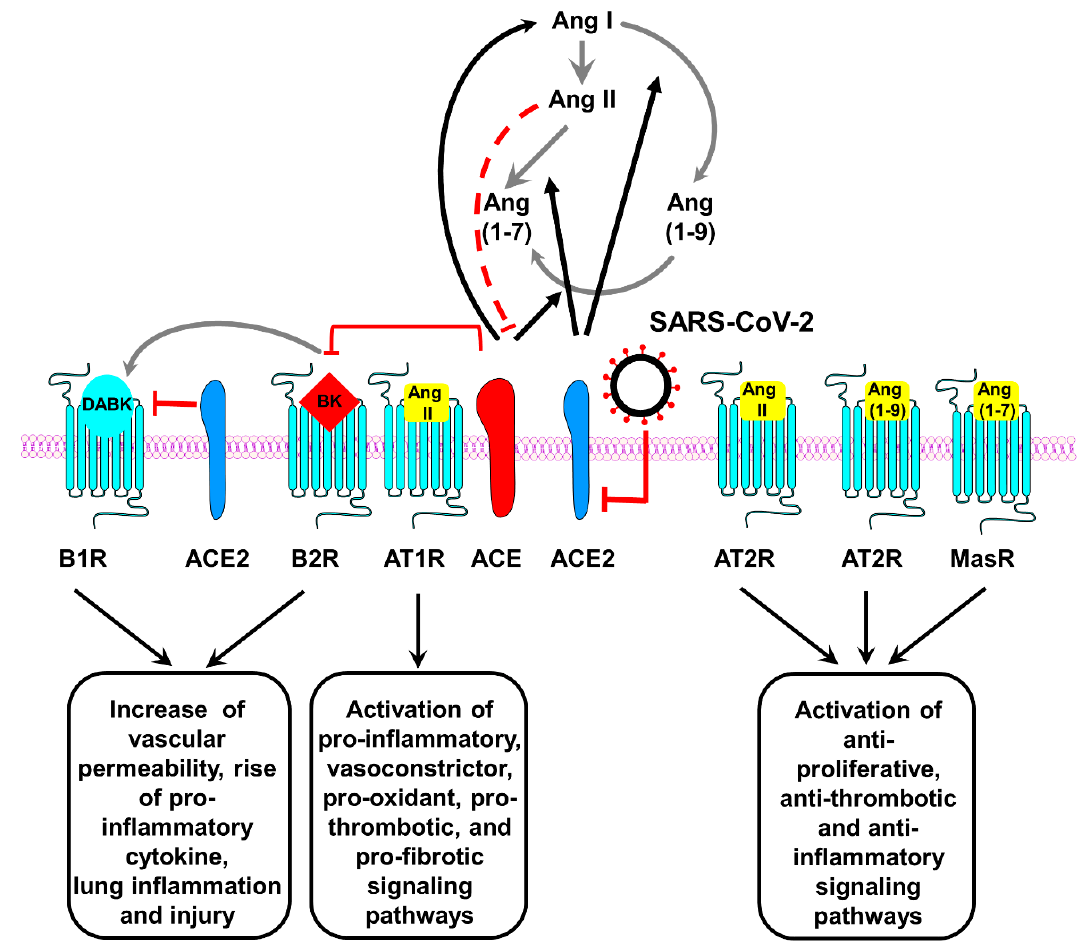
Figure 2. Role of the Renin–Angiotensin Systems in the pathobiology of SARS-CoV-2 infection. Black arrows indicate enzymatic activation; red lines represent inhibition or degradation / downregulation. Dashed red lines entail the involvement of other molecules (not depicted) to inhibit the molecule indicated at the end of the line. Gray arrows indicate conversion of one molecule into another. ACE, angiotensin converting enzyme; ACE2, angiotensin converting enzyme 2; Ang I, Angiotensin I; Ang II, Angiotensin II; Ang (1-7), Angiotensin 1-7; Ang (1-9), Angiotensin 1-9; AT1R, ATII type 1 receptor; AT2R, ATII type 2 receptor; B1R, B1 receptor; B2R, B2 receptor; BK, bradykinin; DABK, [des-Arg9]-BK; MasR, Mas receptor. Modified from [27] .